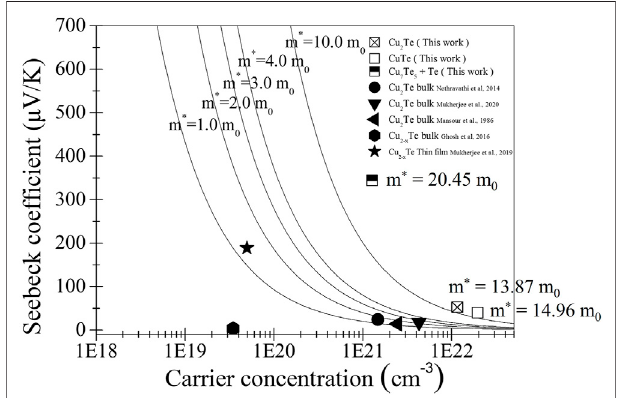
FIGURE7|(A) PotentialwellschemeattheinterfacebetweentheintermetalliccoppertellurideandTemetalphases.UPSspectraacquiredforcalculatingthework functions of: (B) Cu 0.5 Te, (C) CuTe, and (D) Cu 2 Te.